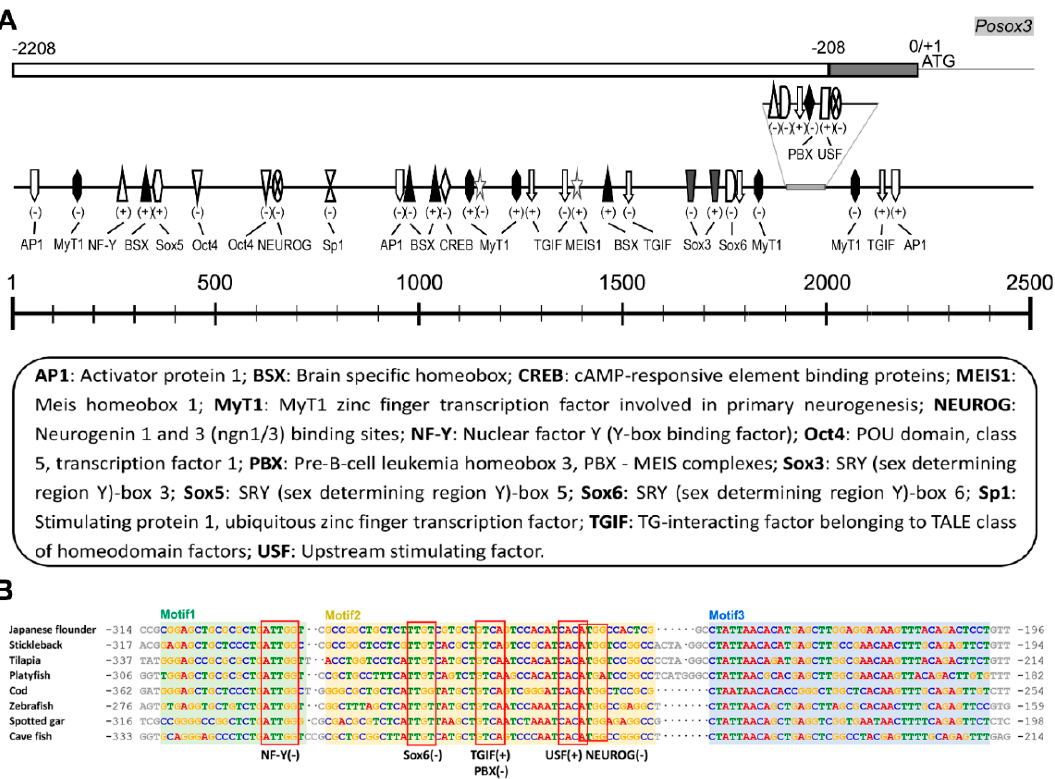
Figure 3. Bioinformatic analyses of the promoter sequence of Posox3 . ( A ) The potential TF binding sites were drawn on the schematic diagram with their corresponding locations within the promoter of Posox3 . The scale is shown above and the detailed information are supplied at the bottom. The plus-minus symbols indicate the strand with which the TFs bind. The gray block represents the conserved upstream region among different fish species. The details for TFs see in Table S1; ( B ) Consensus motif regions in the 5 ′ upstream sequences of different fish sox3 orthologs analyzed by software MEME and Dialign. The GenBank accession number of Japanese flounder ( Paralichthys olivaceus ) sox3 was KT314157. Other sox3 5 ′ -flanking sequences were searched from Ensembl [28] and their gene IDs were as follows: Stickleback ( Gasterosteus aculeatus ) sox3 : ENSGACG00000017181; Tilapia ( Oreochromis niloticus ) sox3 : ENSONIG00000020861; Platyfish ( Xiphophorus maculatus ) sox3 : ENSXMAG00000019515; Cod ( Gadus morhua ) sox3 : ENSGMOG00000020190; Zebrafish ( Danio rerio ) sox3 : ENSDARG00000053569; Spotted gar ( Lepisosteus oculatus ) sox3 : ENSLOCG00000017493; Cave fish ( Astyanax mexicanus ) sox3 : ENSAMXG00000025368. The potential TF (NF-Y, Sox6, TGIF/PBX, USF, and NEUROG) binding sites within the conserved motifs are boxed and indicated above the aligned sequences.